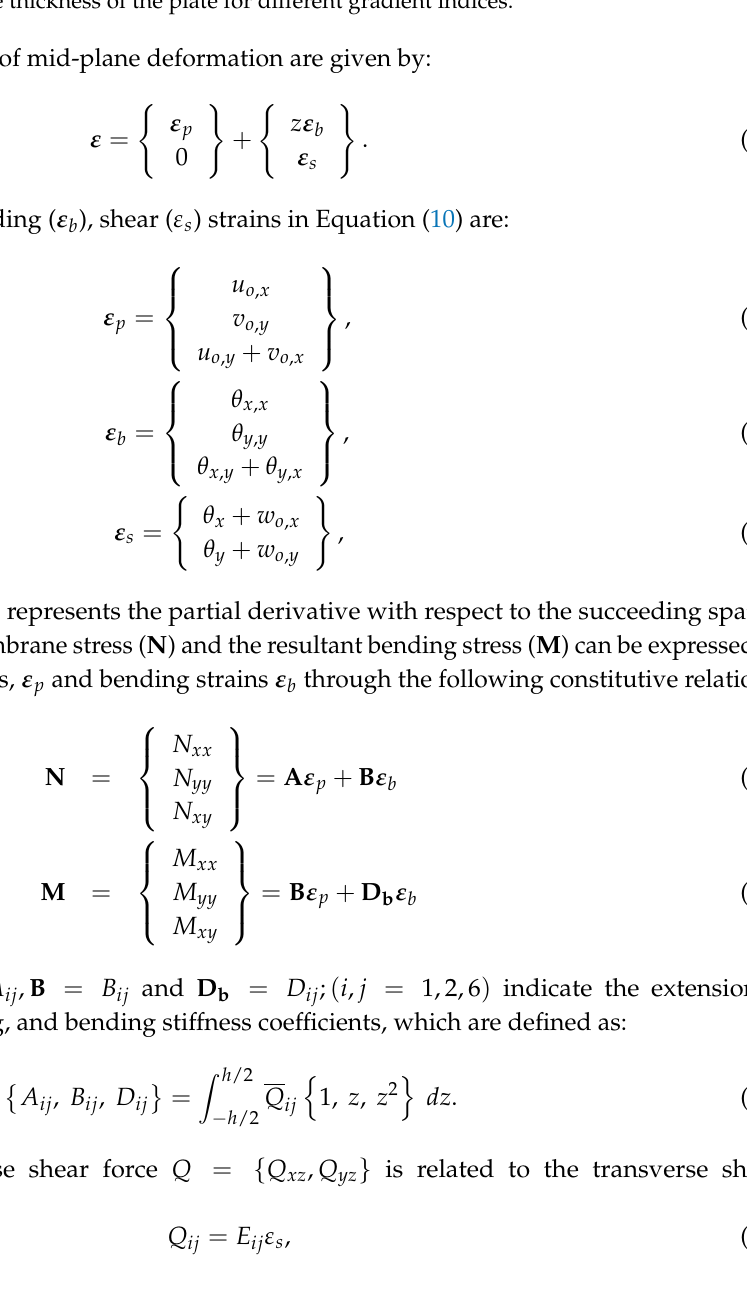
Figure 1. Functionally graded rectangular plate: ( a ) geometry and ( b ) volume fraction of ceramic and metallic phases through the thickness of the plate for different gradient indices.